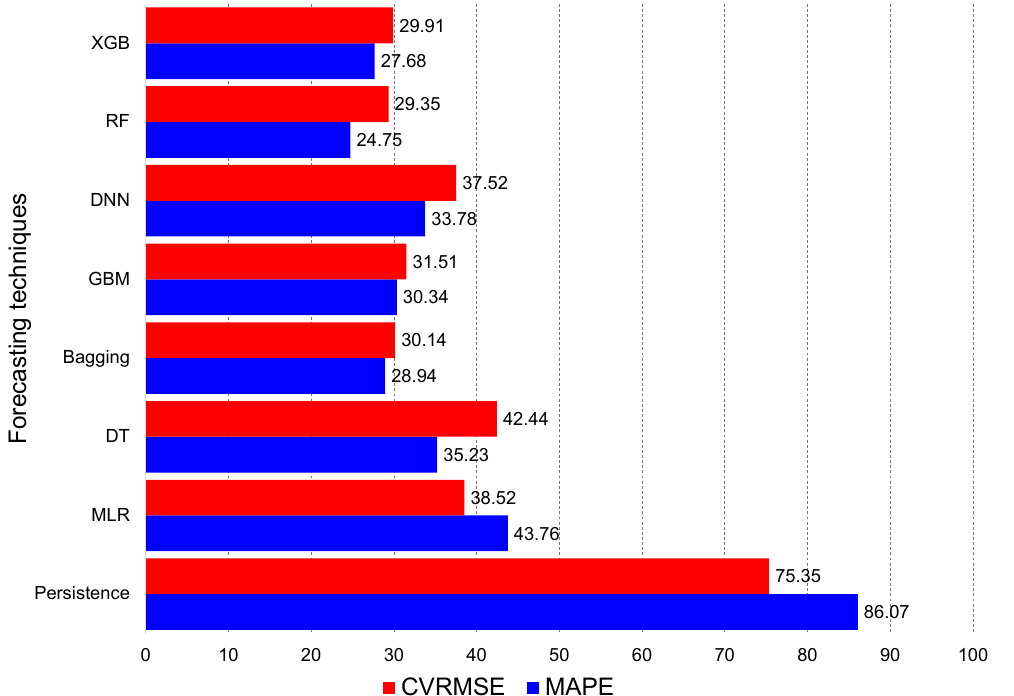
Figure 4. CVRMSE and MAPE comparison of machine learning algorithms.